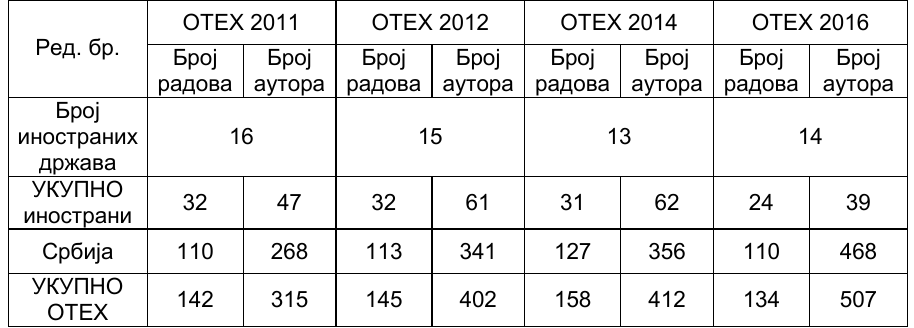
Table 4 – Overview of the number of papers and authors/coauthors by the member states O ТЕХ 2011 ОТЕХ 2012 ОТЕХ 2016 Ред . бр